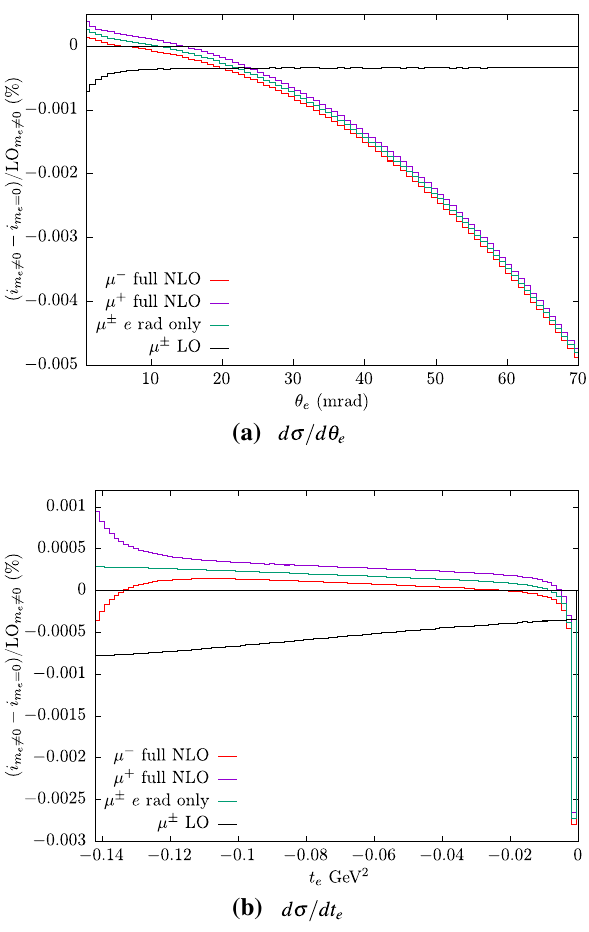
Fig. 14 The relative contribution of finite electron-mass corrections to the cross section of the processes μ ± e − → μ ± e − , as a function of the electron scattering angle and the momentum transfer. The predictions refer to Setup 1 defined in the